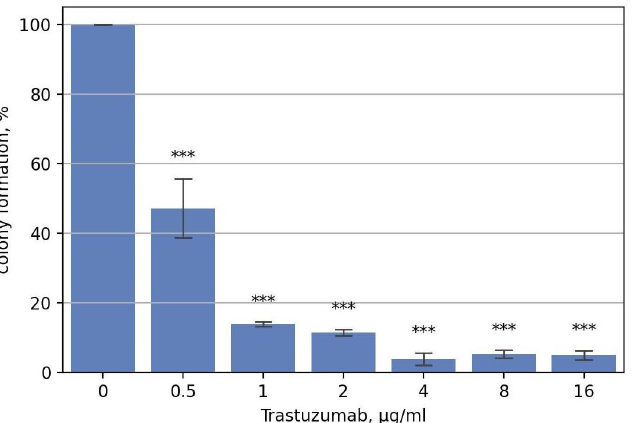
Figure 2. BT474 cells colony formation upon the treatment with trastuzumab (concentration is given in µg/mL) in the presence of 12.5% of heat-inactivated FBS. The data are presented as mean ± standard deviation from three independent replicates. *** — p -value < 0.001.